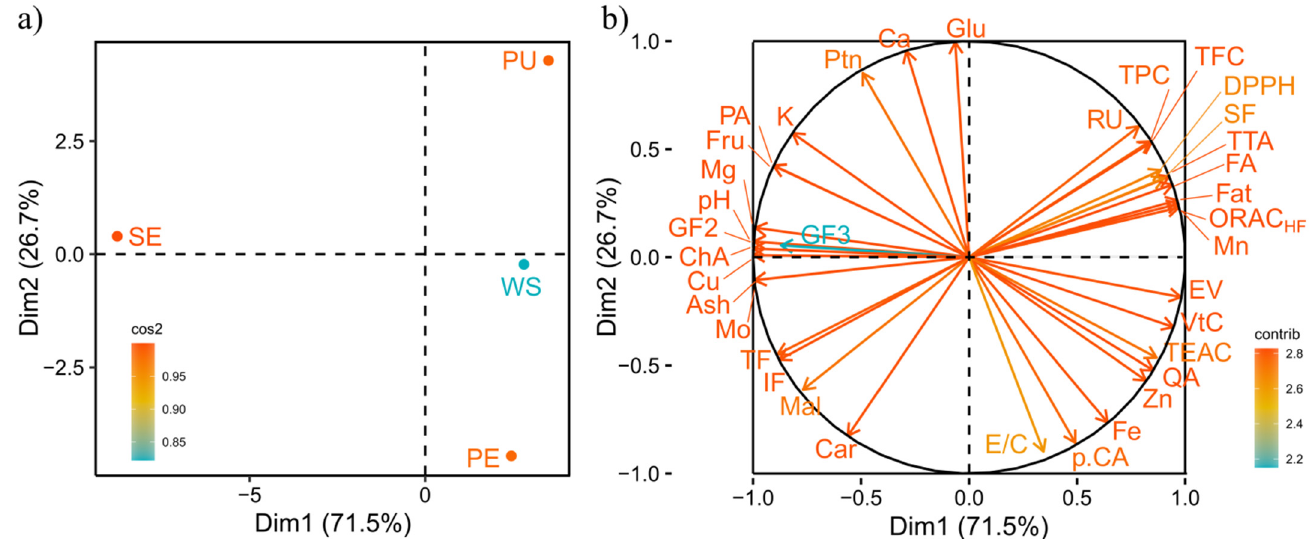
Figure 2. Graphical representation of the Principal Component Analysis (PCA) of the buritirana fruit fractions: ( a ) Fractions: WS: whole without seed; PU: pulp; PE: peel; and SE: seed. ( b ) Responses of proximate composition, carbohydrate profile, physicochemical characteristics, vitamin C content,